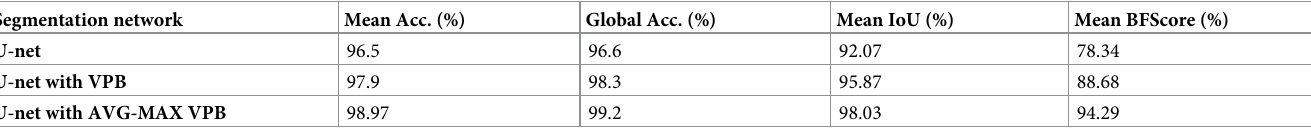
Table 2. Semantic segmentation evaluation metrics of U-net before and after using VPB and AVG-MAX VPB. Segmentation network Mean Acc.